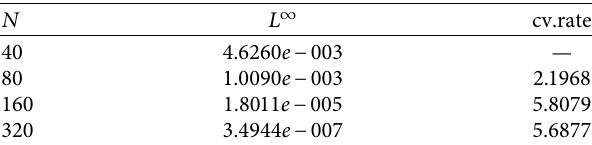
Figure 2: Absolute error of Example 1 with the two-stage, second-order ERK method and WENO5 scheme for different CFL numbers at T � 0 . 1 , N � 10240 , and α � 0 . 9. (a) σ � 0 . 3, (b) σ � 0 . 5, (c) σ � 0 . 8, and (d) σ � 1 . 1. Table 2: The L ∞ errors and convergence rates of Example 2 with Table 1: Errors and convergence rates of Example 1 with the third- the third-order TVD ERK method and WENO5 scheme for α � 0 . 9 order TVD ERK method and WENO5 scheme for α � 0 . 9 and σ � 0 . 4 at T � 0 .